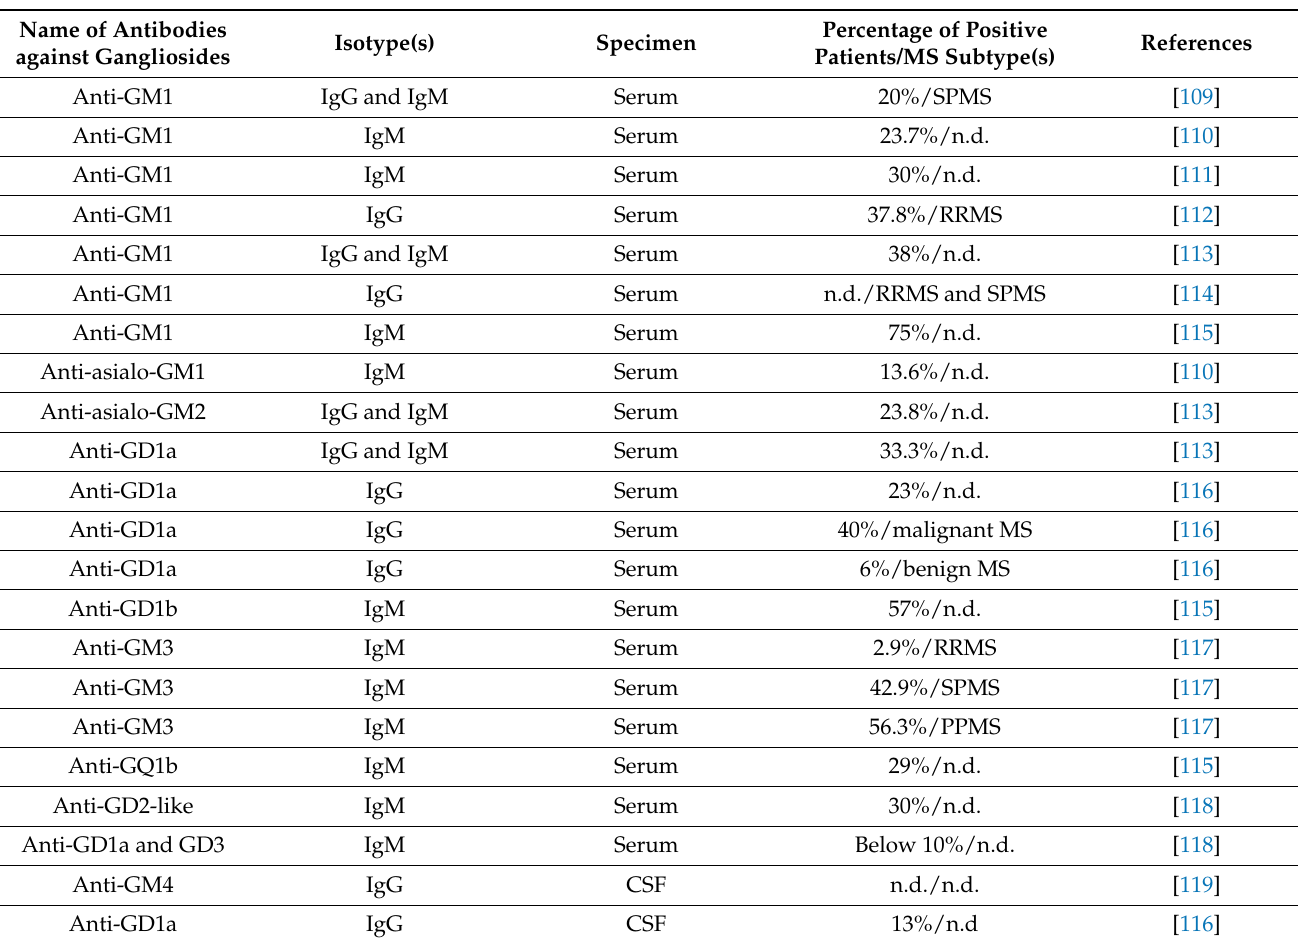
Table 3. Anti-ganglioside antibodies in